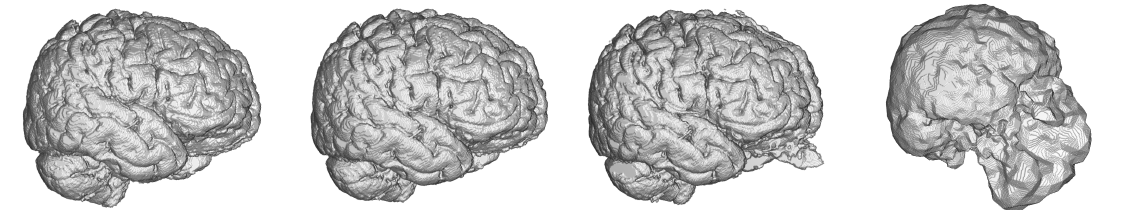
Figure 7. Visualisation of predictions from 3D benchmark brain models and FSL segmentation. From left to right—Dense-U-Net, Residual-U-Net, U-Net, FSL.